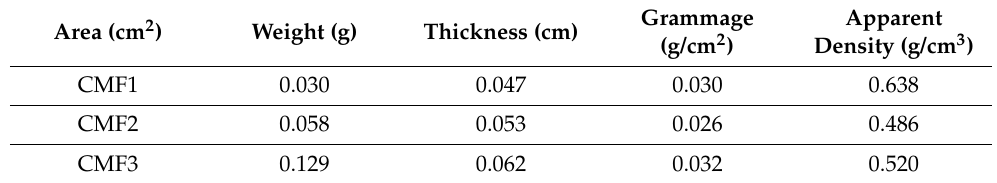
Table 2. Physical properties of the CMF